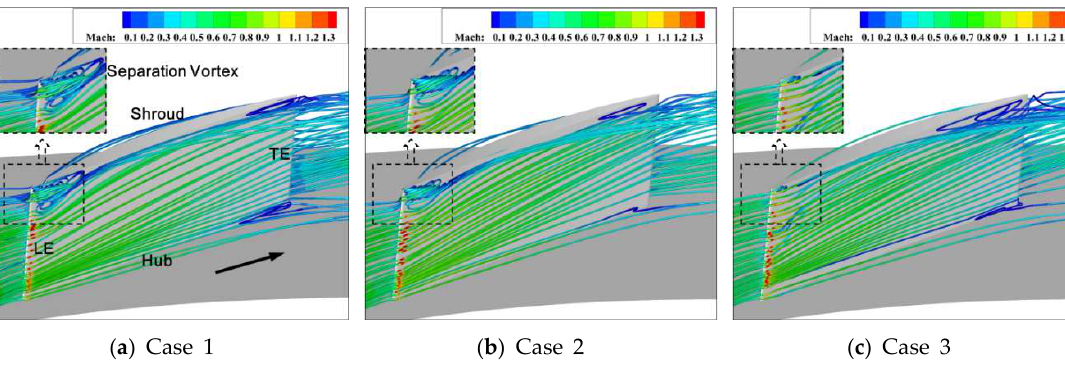
Figure 14. 3-D streamlines near the diffuser vane